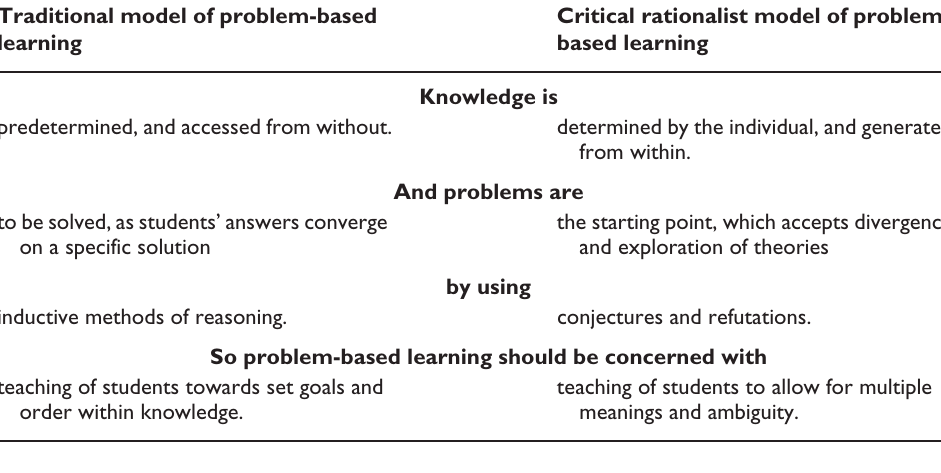
Table 1. A critical rationalist model of problem-based learning. Traditional model of problem-based learning predetermined, and accessed from without. determined by the individual, and generated